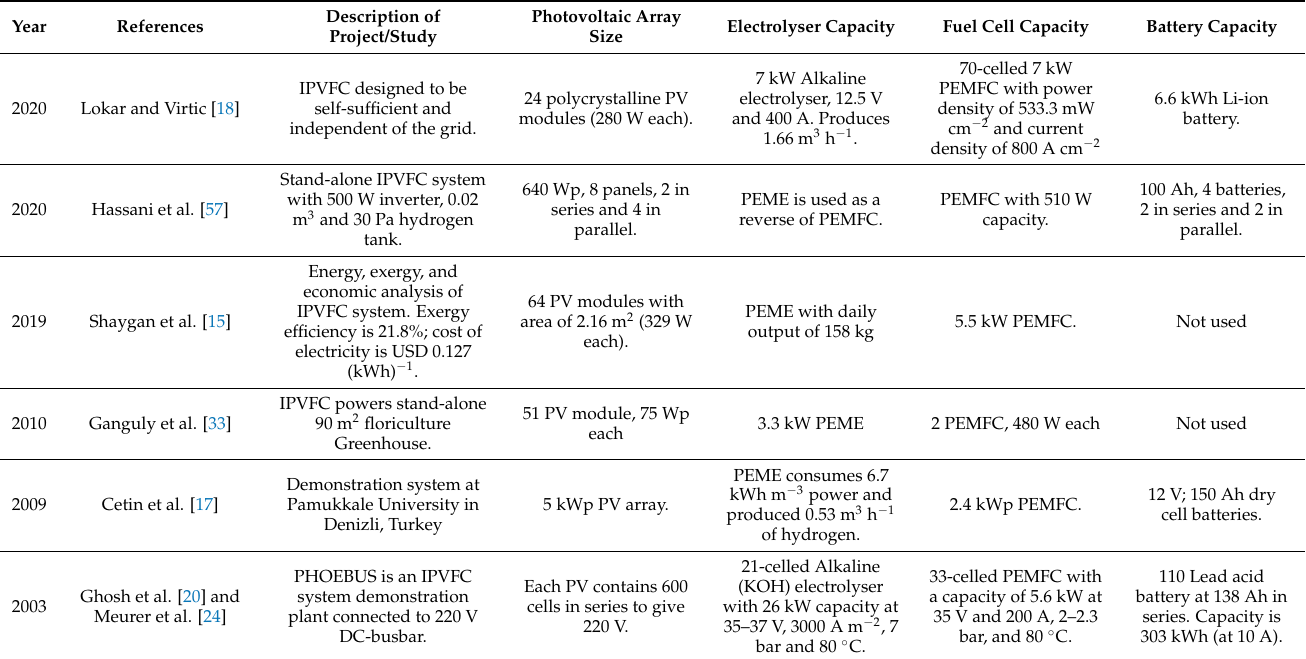
Table 1. Description of key studies on IPVFC